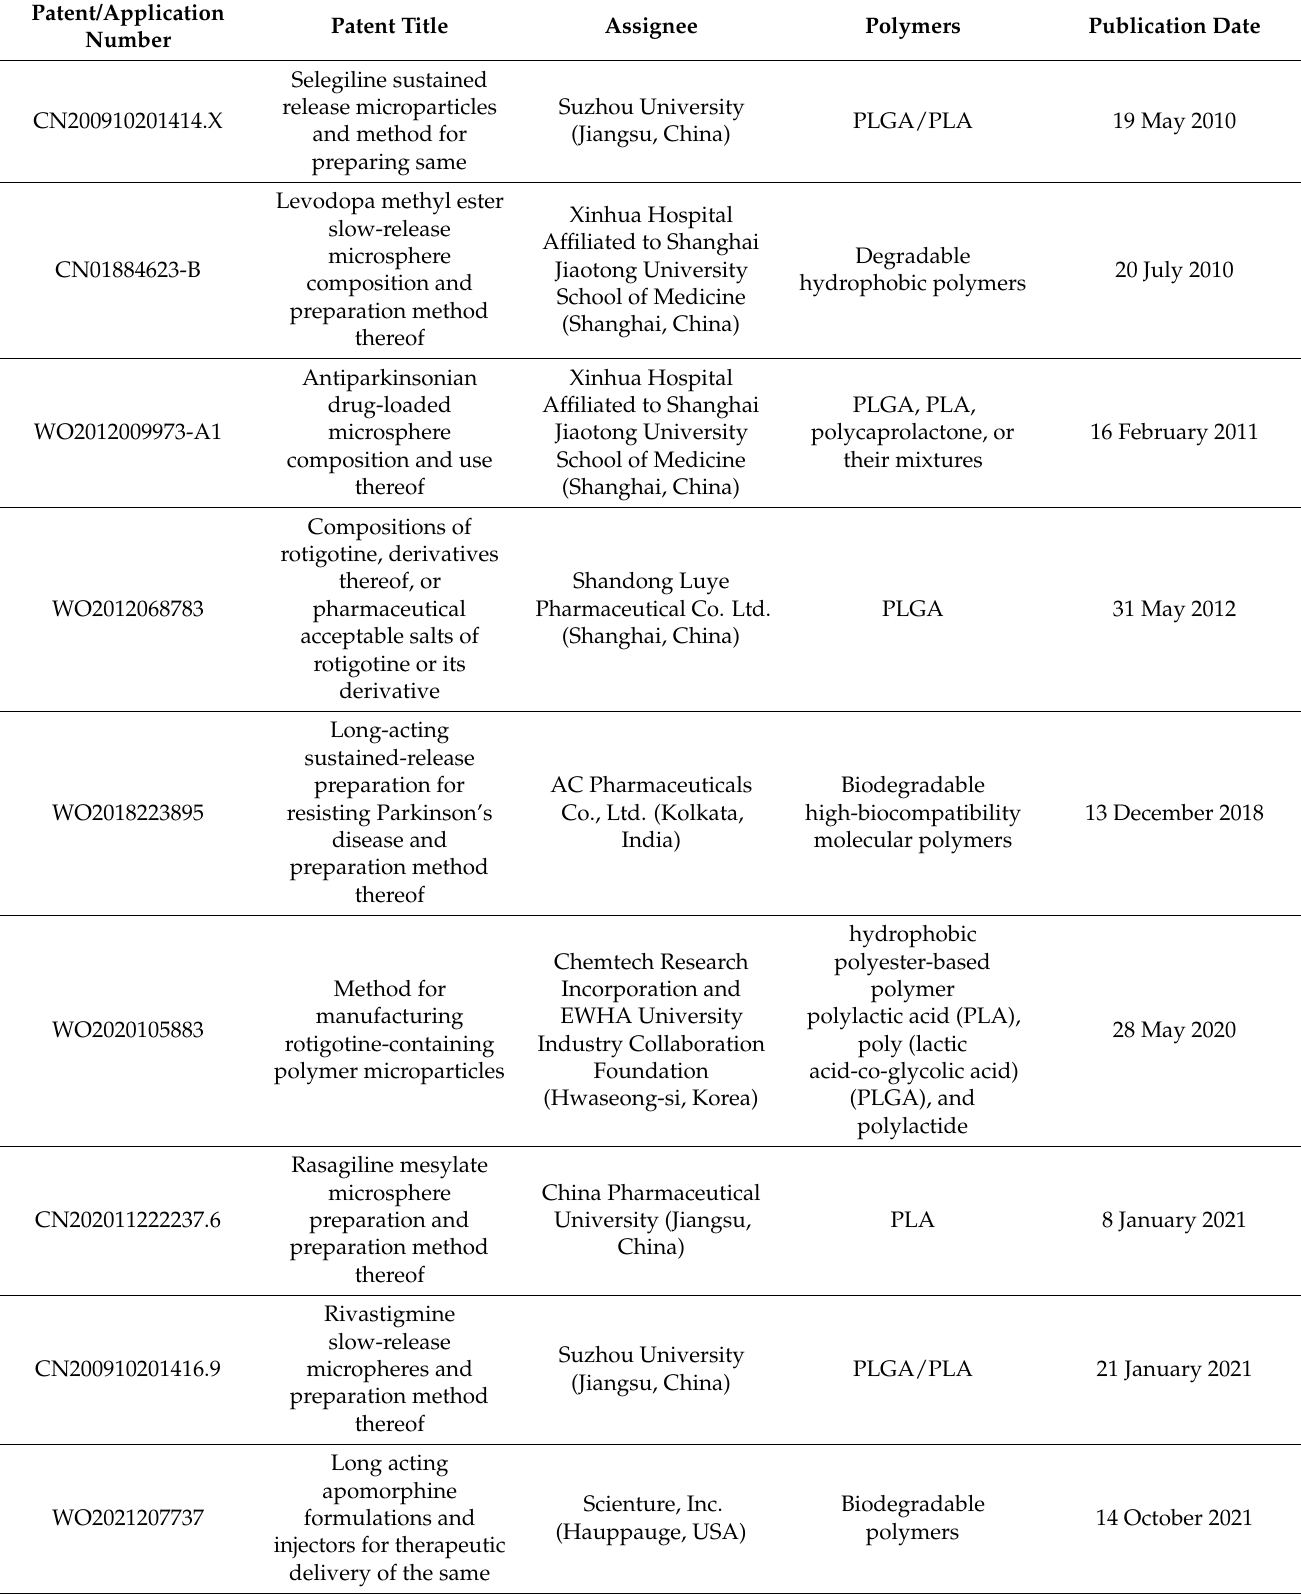
Table 3. Patents related to polymeric microparticulate systems for PD filed recently